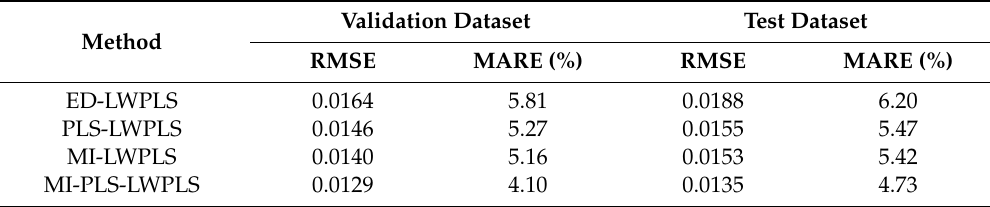
Table 4. Statistical analysis of prediction errors of the debutanizer column process (DCP) dataset.